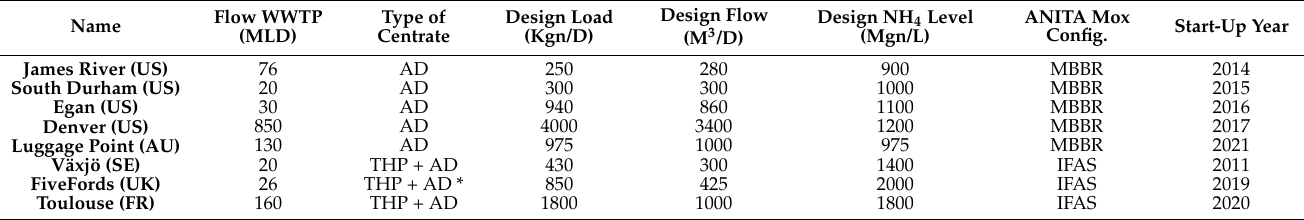
Table 1. ANITA Mox case studies treating conventional AD or THP + AD centrate presented in this paper.